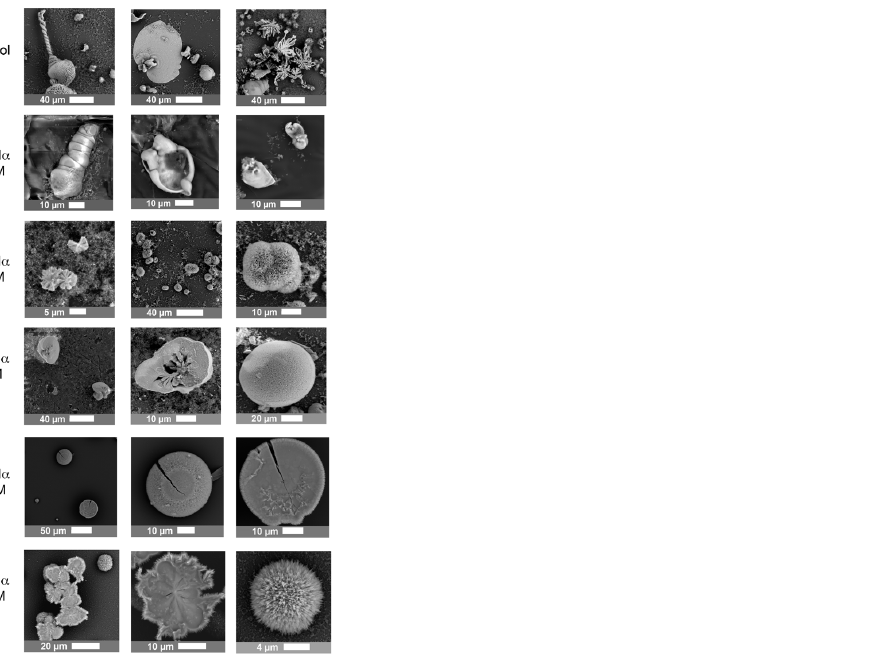
Figure 5. Selection of SEM micrographs from barium silica carbonate biomorphs obtained at 25 ◦ C in the presence of different concentrations of silicatein- α . Sd_Sil α — Suberitis domuncula silicatein- α , Ta_Sil α — Tethya aurantia silicatein- α .